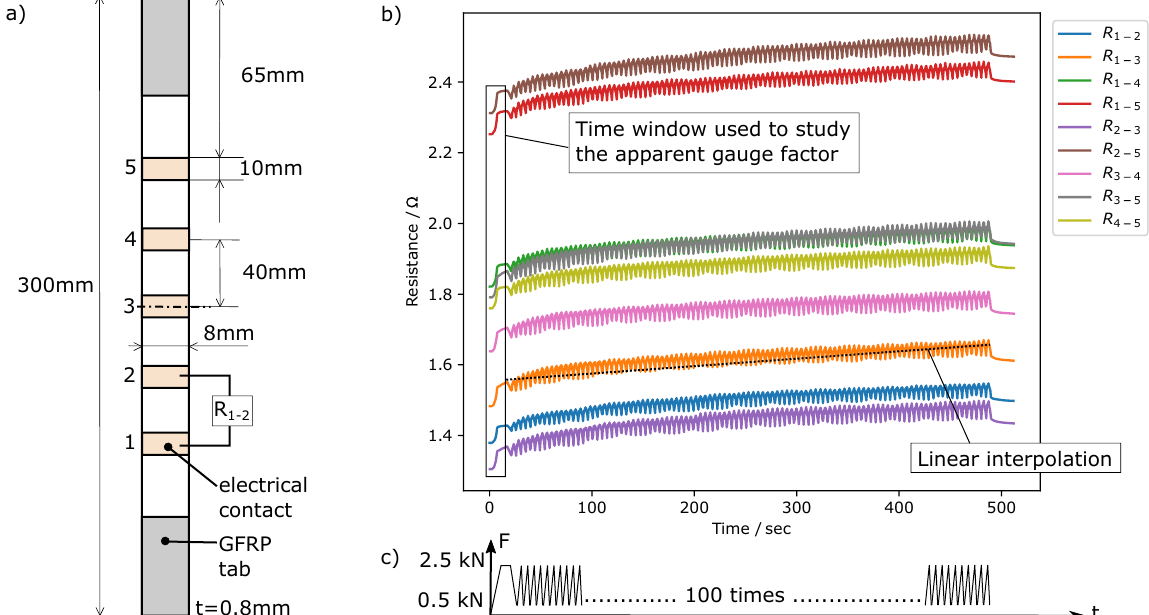
Figure 5. Experimental setup and results for measuring the resistance development with strain cycles. ( a ) Specimen dimensions used in this study. ( b ) Results of a sanded specimen contacted with electrodeposited nickel and solder during the first 100 strain cycles. ( c ) Force over time showing the strain cycle of each specimen. * The resistance R 2 − 4 was excluded due to a wiring problem that was only found after the experimental study was